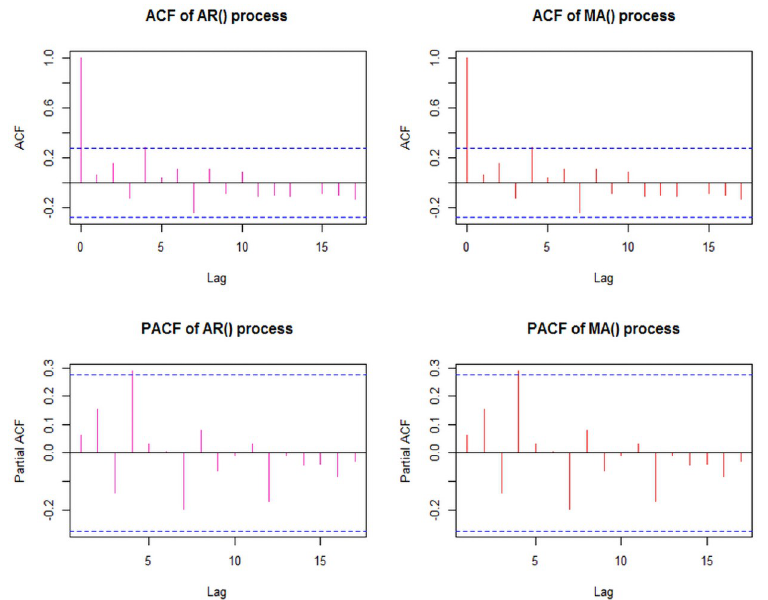
Fig 5. ACF and PACF plot of suicide rate in India.